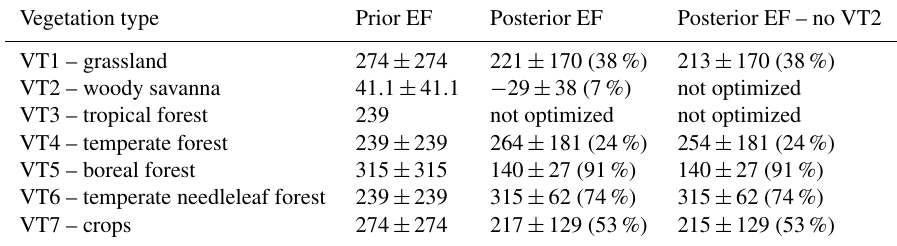
Table 2. Prior and posterior emission factors (EFs) used to generate emissions estimates. Prior EFs are from Wiedinmyer and Friedli (2007). All EFs are given in units of × 10 − 6 gHg ( kg fuel burned ) − 1 . The error reduction is given in brackets for the posterior